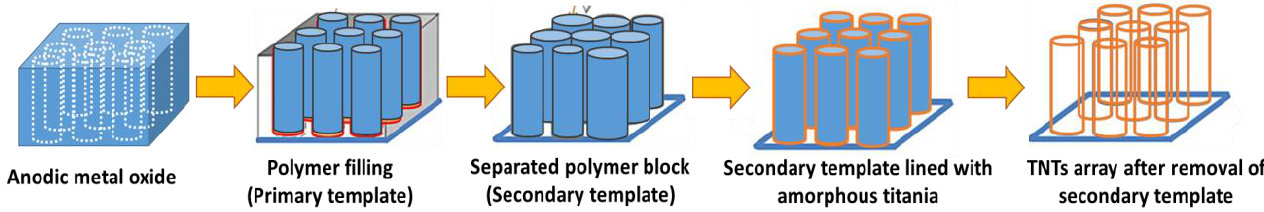
Figure 2. Synthesis of TNTs via template-assisted method.